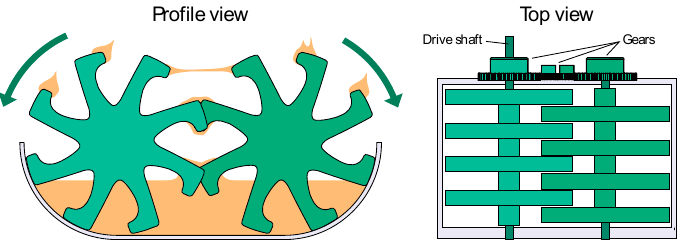
Figure A10. Counter-rotating carding brushes. Pinwheel like disks rotate in a bath such that they smear and then stretch strands which initiate electrospinning.